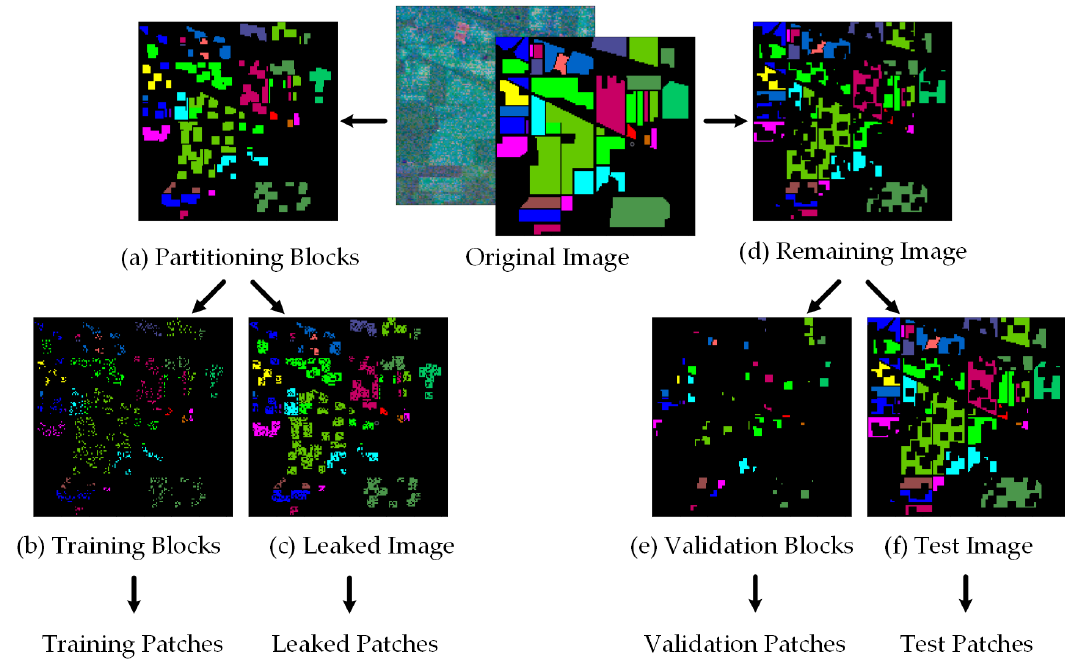
Figure 6. Training-test set splits: ( a ) random partitioning blocks, ( b ) training blocks, ( c ) leaked image, ( d ) remaining image, ( e ) validation blocks, ( f ) test